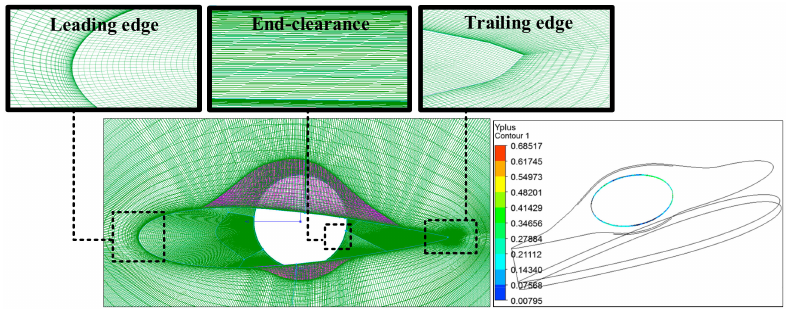
Figure 7. Computational grid and y + values for the clearance flow